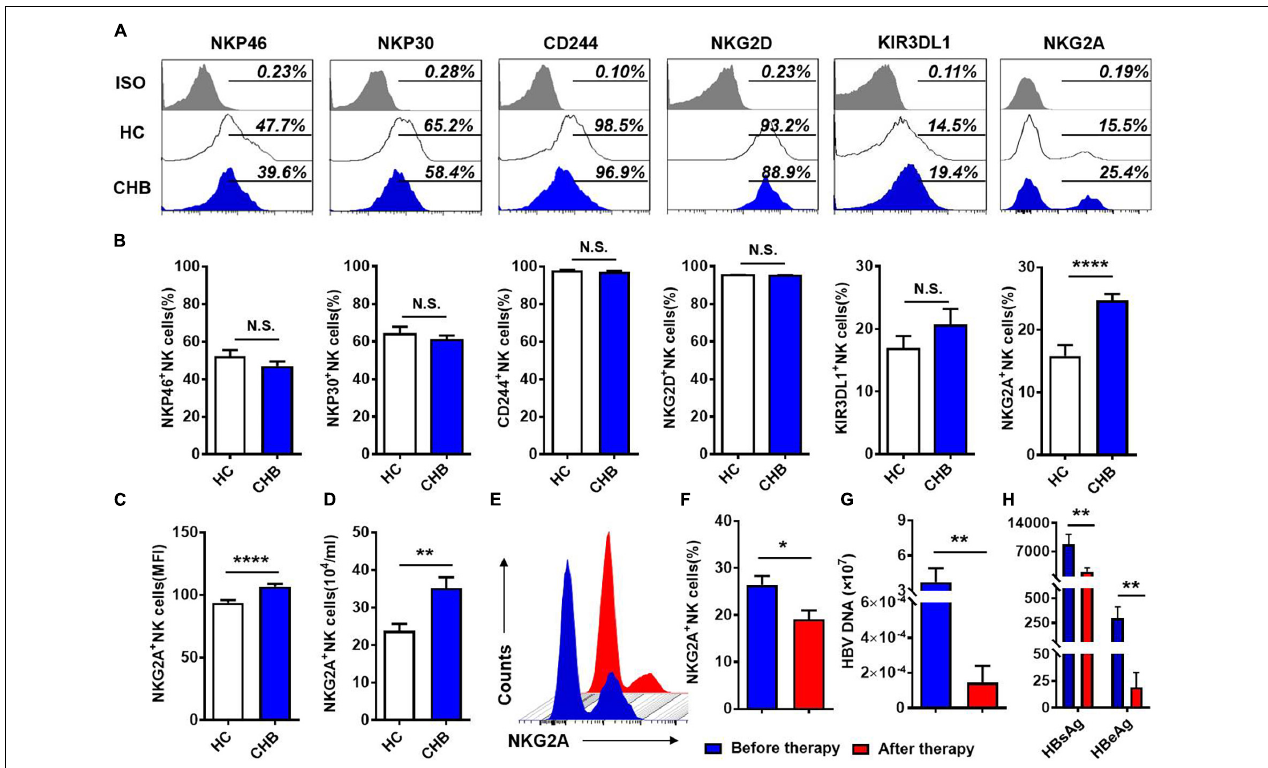
FIGURE 1 | NKG2A expression is increased on circulating NK cells in patients with CHB. (A) Representative flow cytometry plots showing expression of NKG2A, KIR3DL1, NKP46, NKP30, CD244, NKG2D, and their isotype controls on peripheral NK cells from patients with CHB and healthy controls. (B) Comparison of the percentages of receptors in (A) expressed on peripheral NK cells in patients with CHB. (C) Mean fluorescence intensity (MFI) of NKG2A expression on peripheral NK cells in patients with CHB and healthy controls. (D) Absolute numbers of NKG2A + NK cells in peripheral blood samples from patients with CHB and healthy controls. z Representative flow cytometry plots showing NKG2A expression on peripheral NK cells from patients with CHB before and after antiviral therapy. (F) The percentage of NKG2A + NK cells in CHB patients before therapy and after therapy. (G) The HBV-DNA titers of CHB patients before therapy and after therapy. (H) The serum HBsAg and HBeAg levels of CHB patients before therapy and after therapy. Data are representative of more than three independent experiments. Results are presented as the mean ± SEM ( n ≥ 3 per group) and unpaired/paired two-tailed Student’s t -tests were conducted; * p < 0.05, ** p < 0.01, **** p < 0.0001; N.S., not